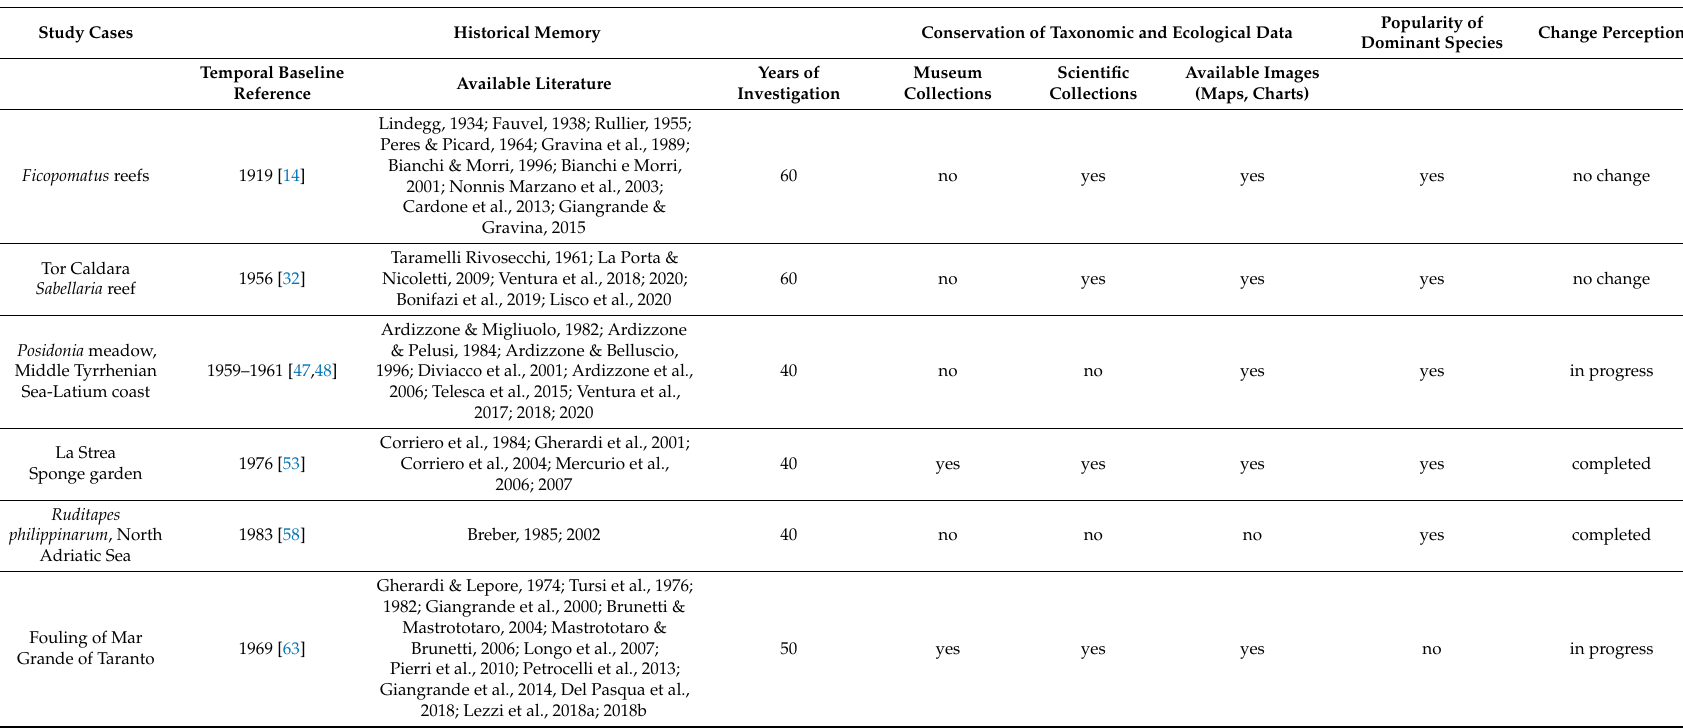
Table 1. Criterions of understanding changes of the study cases. In brackets the references of the temporal